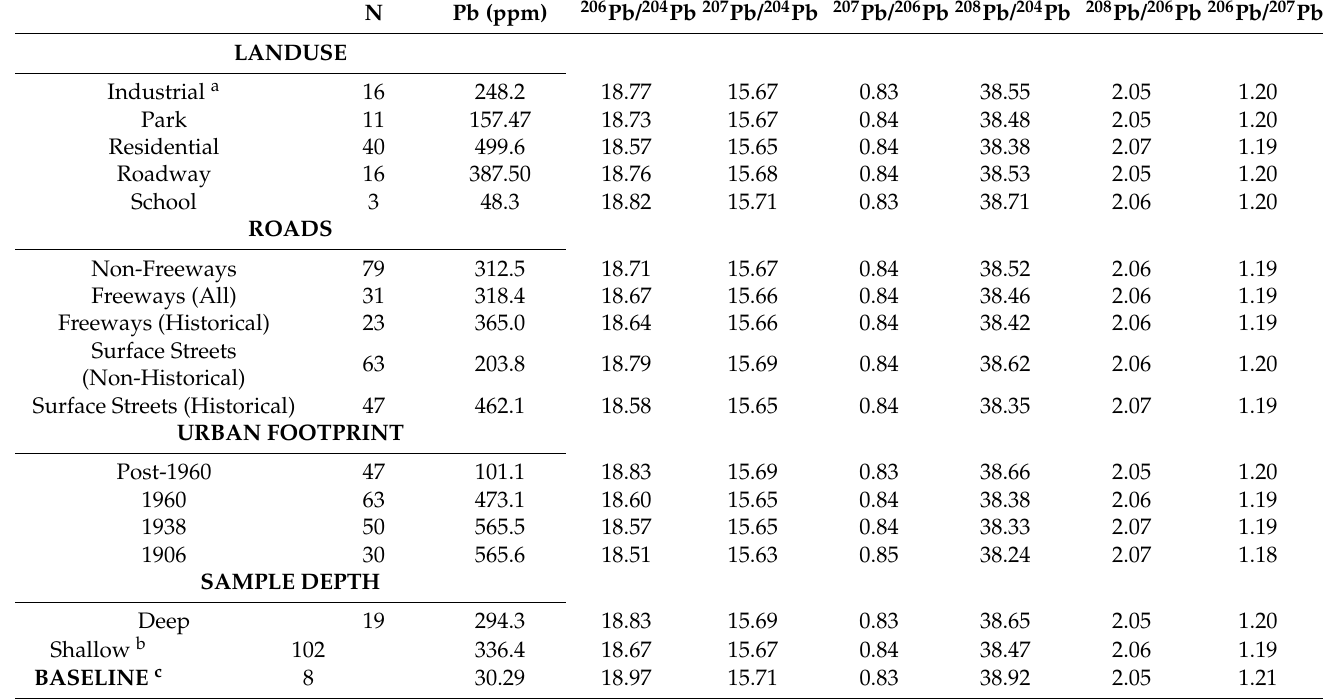
Table 1. Lead concentrations and isotopic ratios averaged by spatial groupings.